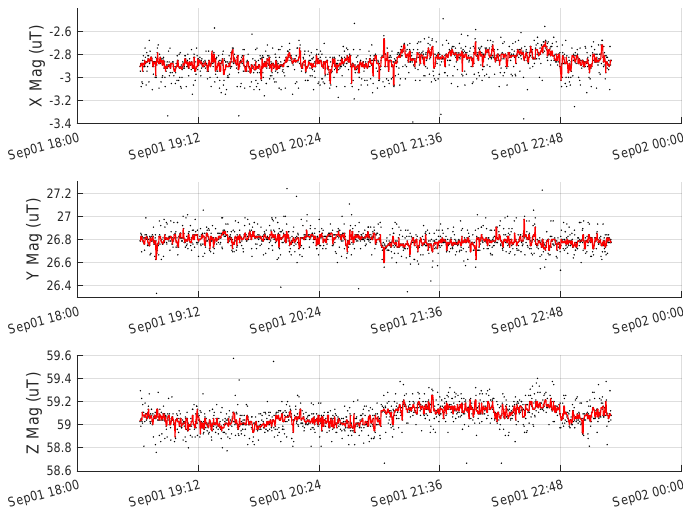
Figure 9. Data from 1 September 2022, during the t6_XX flight